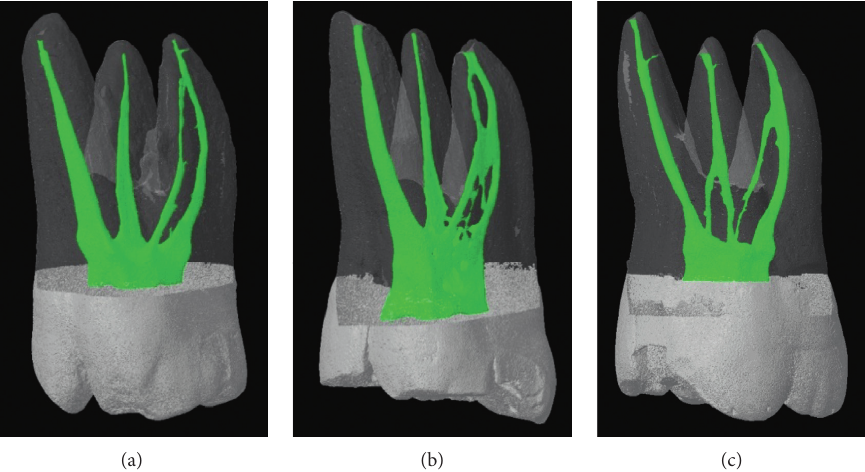
Figure 1: Burmese maxillary first molars with Vertucci’s type II canal in the mesiobuccal root. (a) Mesiobuccal root shows Vertucci’s type II canal with the lateral canal at the apical third, while distobuccal and palatal roots show Vertucci’s type I without lateral canal. (b) Mesiobuccal root shows Vertucci’s type II canal with sheet complete isthmus at the coronal and middle thirds, while palatal and distobuccal roots show Vertucci’s type I canal. (c) Both mesiobuccal and distobuccal roots show Vertucci’s type II canal, while palatal root shows Vertucci’s type I canal with a lateral canal at the apical